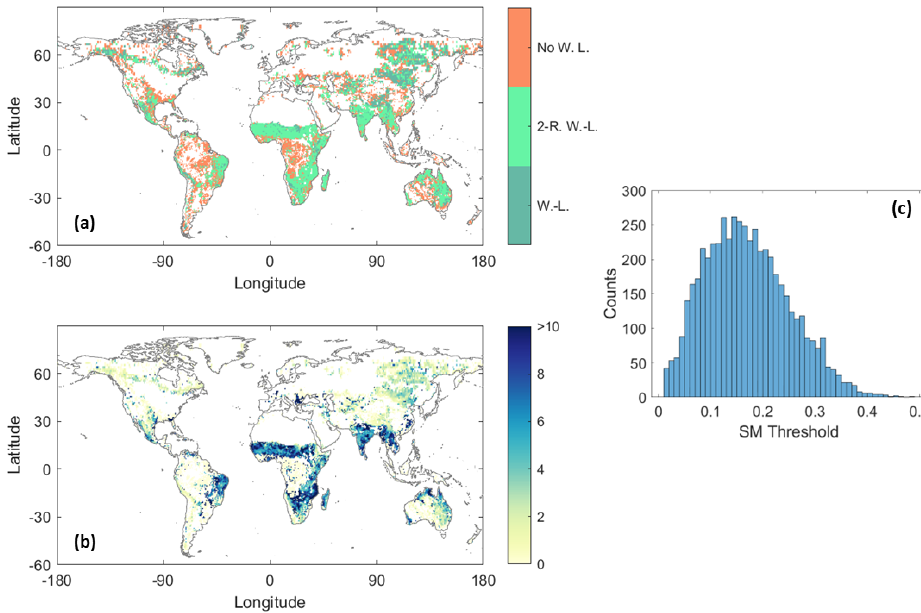
Figure 6. Estimated SIF–soil moisture (SM) relationship features. (a) Model type (W.-L.: water-limited; 2-R. W.-L.: two-regime water- limited; No W. L.: no water limitation), (b) model slope (mWm − 2 nm − 1 sr − 1 ) in the water-limited regime, and (c) model threshold (m 3 m − 3 ) for the SIF–SM relationship. White shading denotes areas where the SIF–SM correlation is not positive – i.e., where SIF is not increasing with SM – or areas where no collocated SIF and SM records are